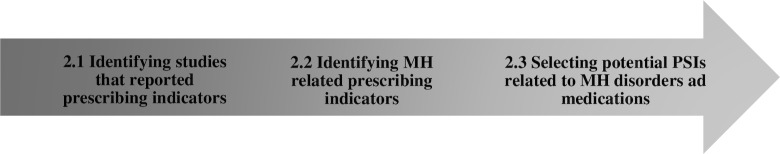
Systematic review stages.MH = Mental health. PSI = Prescribing Safety Indicators.